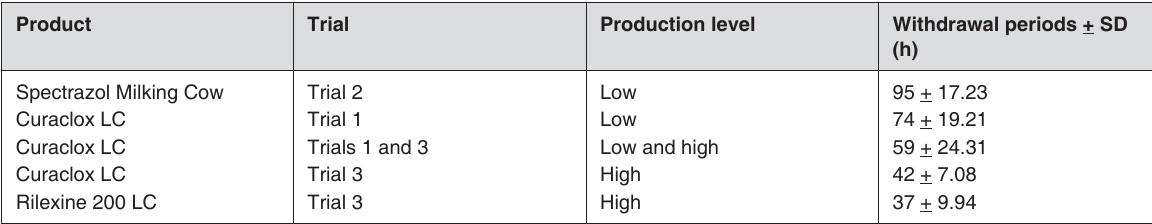
TABLE 2 Milk production levels and antibiotic withdrawal periods as measured by TRIS from Trials 1, 2 and